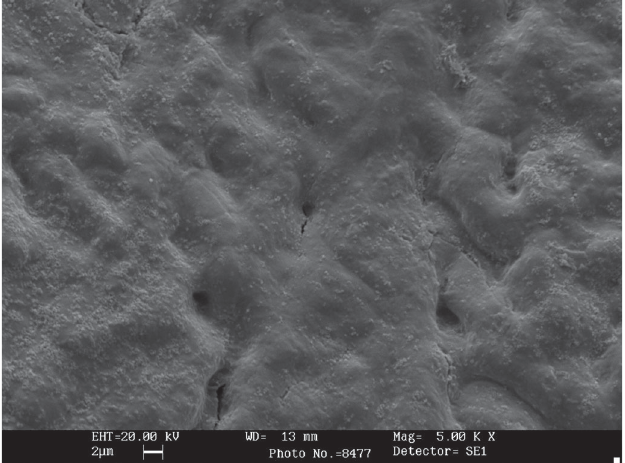
Fig. 3 - SEM image of the ScaPh group showing complete removal of smear layer and smear plug and no acid product residues.